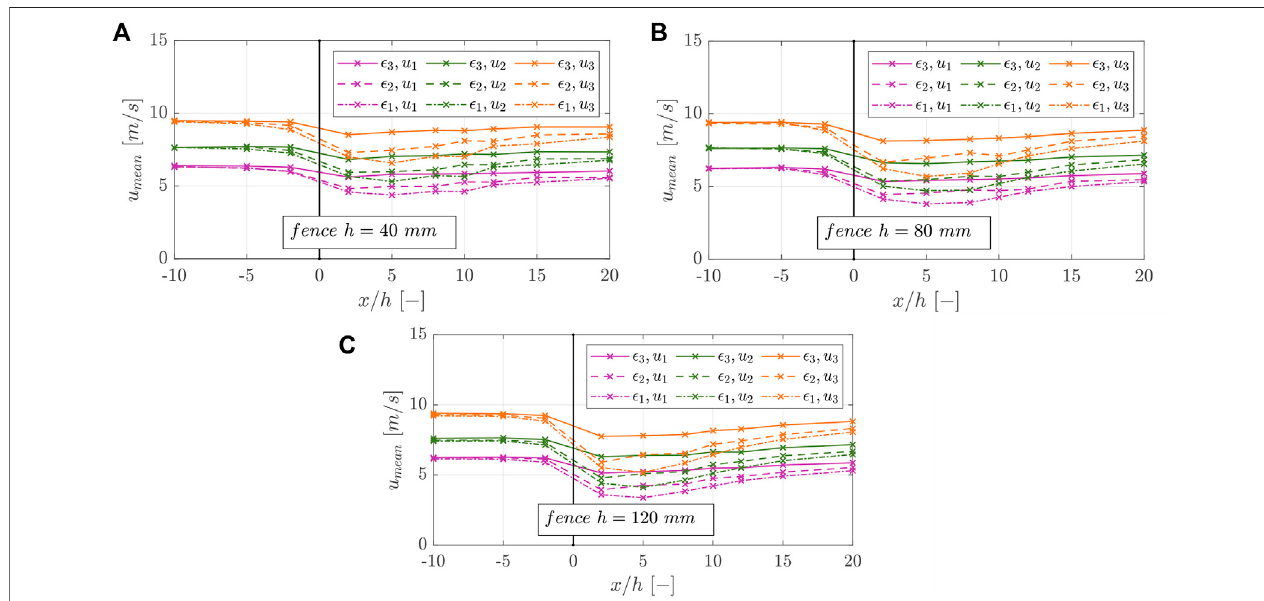
FIGURE8| Mean wind velocity u 1 – u 3 in the x -direction offences with different characteristics ε 1 – ε 3 ,dividedinto (A) the fence heights h 1 =40 mm (B) h 2 = 80 mm, and (C) h 3 = 120 mm.